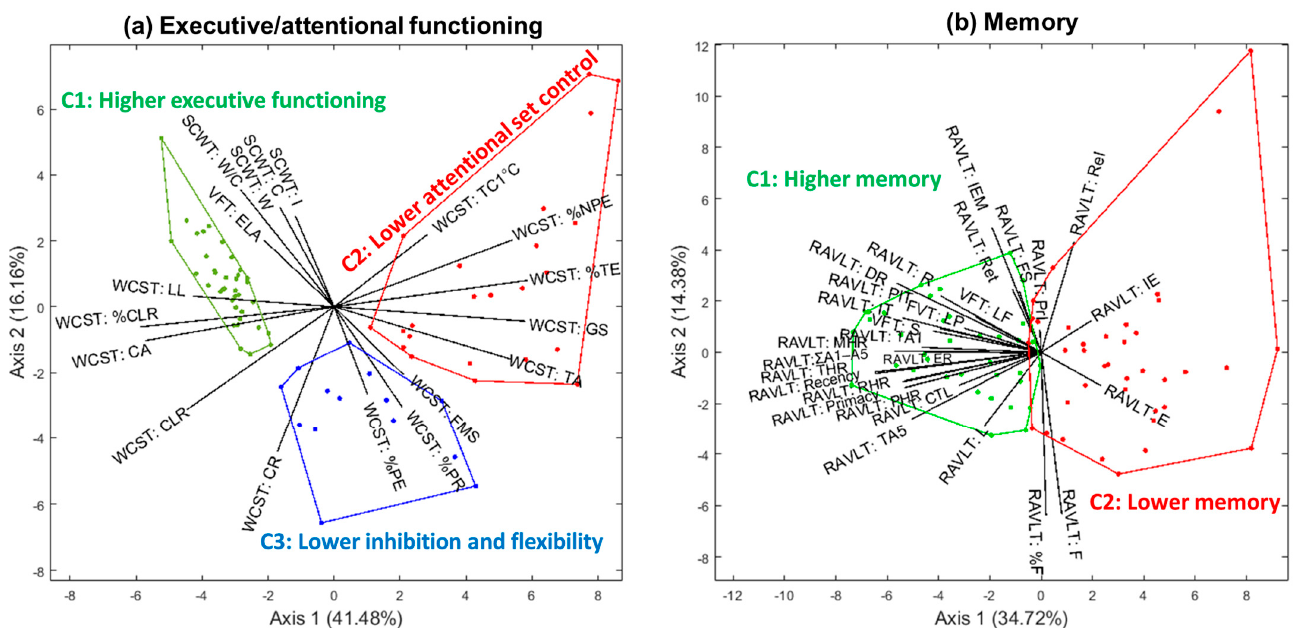
Figure 7. HJ-Biplot representation for clusters in the main plane (axis 1–2) for the executive/attentional functioning ( a ) and memory ( b ) in Argentinian postpartum women. SCWT = Stroop color and word test; I = Interference; C = Color; W = Word; W/C = Word-Color; WCST = Wisconsin card sorting test; TC1 °C = Trials to complete first category; %NPE = Percentage of non-perseverative errors; %TE = Percentage of total errors; GS = Global score; TA = Trials administered; FMS = Failure to maintain set; %PR = Percentage of perseverative responses; %PE = Percentage of perseverative errors; CR = Correct responses; CLR = Conceptual level responses; CA = Categories achieved; %CLR = Percentage of conceptual level responses; LL = Learning to learn; VFT:ELA = Verbal fluency task, excluded letter A; RHR = recency hit rate; MHR = middle hit rate; TA1 = Trial A1; IT = interference trial (B); PIT = post-interference trial (A6); PHR = primacy hit rate; R = recognition; DR = delayed recall; MEI = memory efficiency index; F = forgetting; %F = percentage of forgetting; L = Learning; CTL = Corrected total learning; Σ A1–5 = sum trials A1 to A5; IR, immediate recall; VF-P, verbal fluency letter P; VF-F, verbal fluency letter F; VF-Animals, verbal fluency Animals; PrI = proactive interference; ReI = retroactive interference; TA5 = trial A5; E = evocation; Ret = retention; IE = Intrusion errors; ER = errors of repetitions; FS = forgetting speed; VFT = verbal fluency task; LF = letter F; LP = letter P; S = semantic.